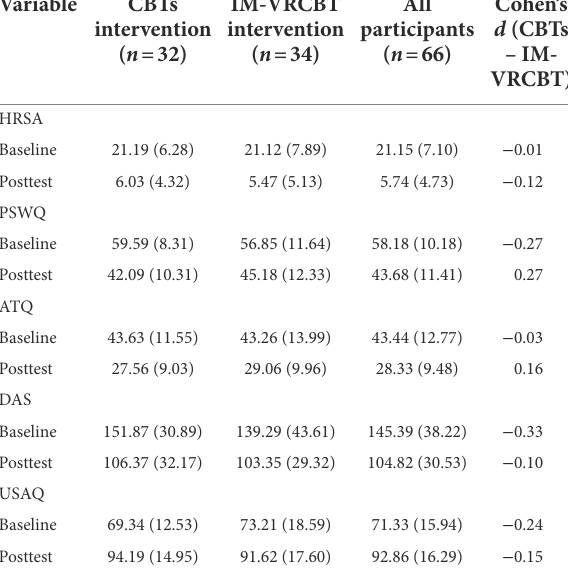
TABLE 1 Mean (SD) for the participants in the two groups and the entire sample included in